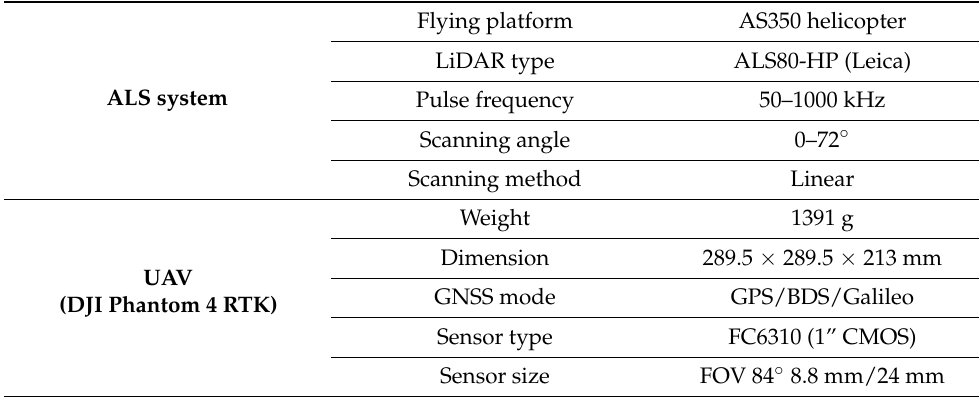
Figure 4. Comprehensive point cloud model obtained by two different remote sensing tech- niques: ( a ) the main workflow of point cloud acquisition; ( b ) airborne LiDAR ground point cloud (22,659,861 points); ( c ) sparse 3D point cloud generation using SfM technique; ( d ) UAV true-colour point cloud (39,168,188 points) aligned with LiDAR ground point cloud (HSV-coloured). Table 1. Key technical